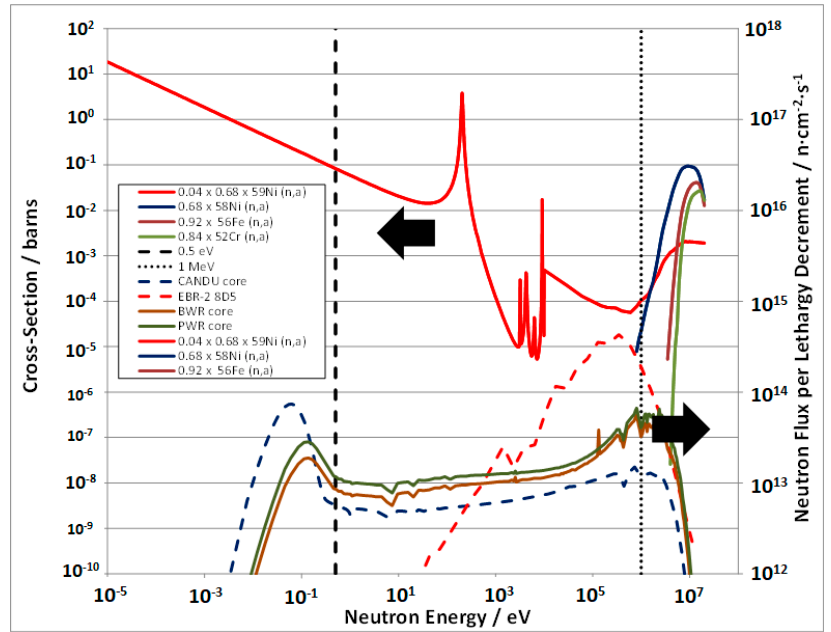
Figure 3. Neutron spectra for PWR, BWR, CANDU and EBR-II reactors (right hand scale) and (n, α ) cross-sections for the major isotopes of Ni, Fe, Cr and Zr scaled for atomic abundance (left hand scale). Also shown is the 59 Ni (n, α ) reaction cross section scaled for atomic abundance after 5 years operation in a CANDU core.